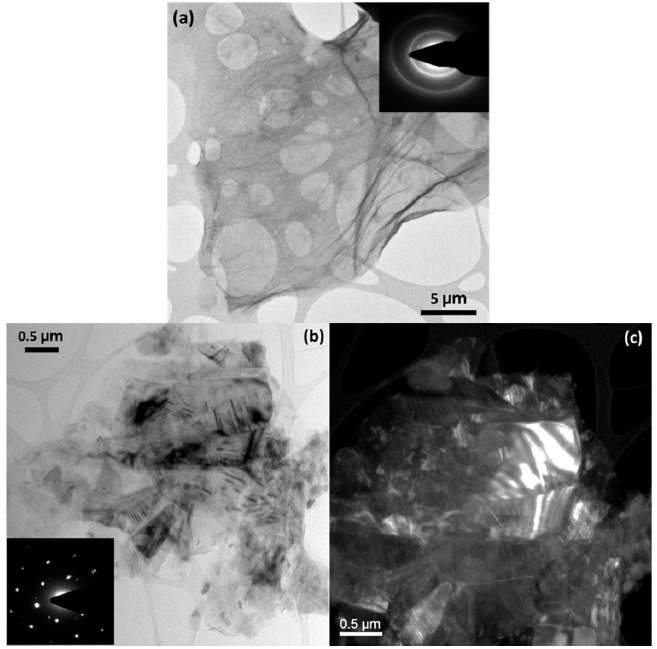
Figure 3. TEM micrographs of ( a ) as-produced GO with SAED pattern and ( b , c ) bright and dark field of RGO H 2 SO 4 12 M with SAED pattern.